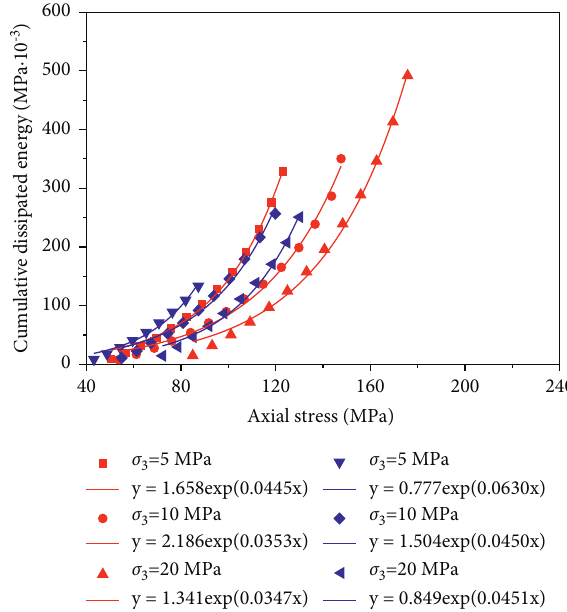
Figure 10: The relationship between cumulative dissipated energy and axial stress (blue denotes saturated phyllite and red denotes dry phyllite; σ 3 is the confining